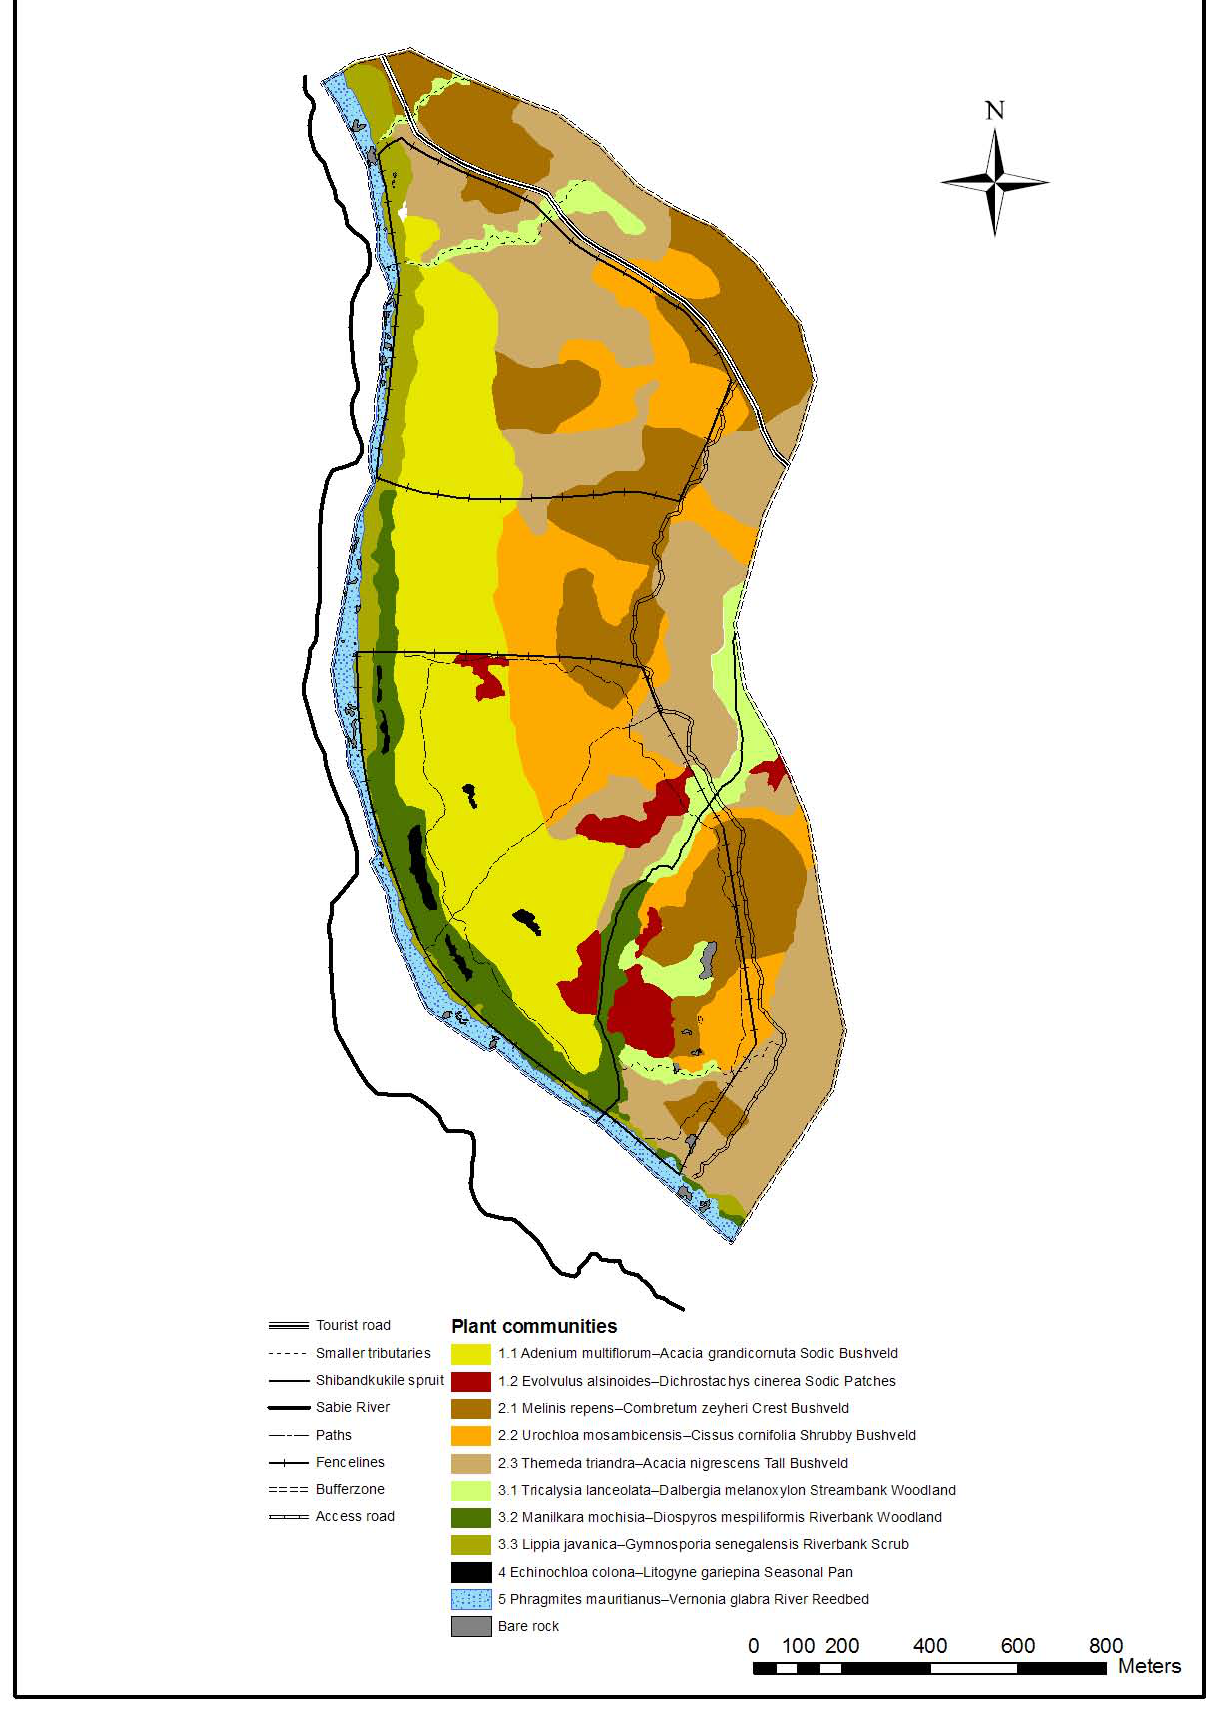
Figure 1 Vegetation map of the Nkhuhlu exclosure